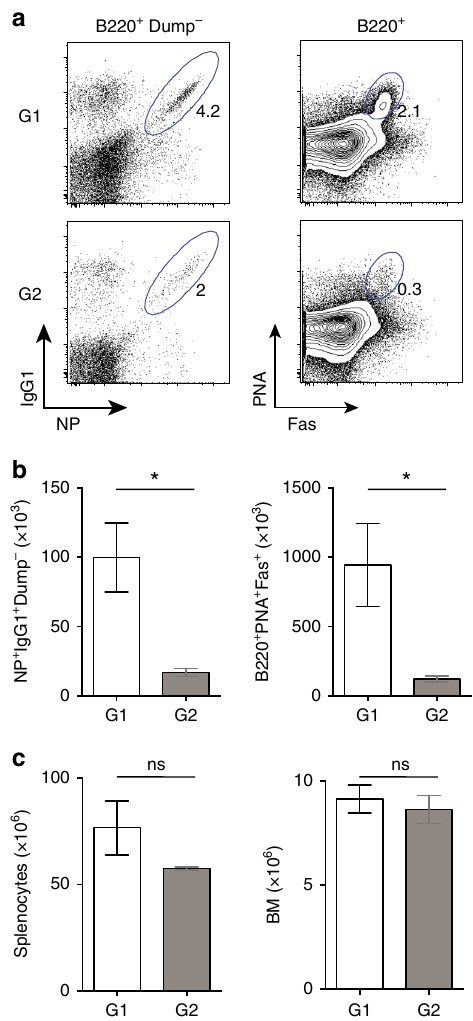
Fig. 6 PRMT1 is required to mount a recall immune response. a – c Irradiation chimeras were generated with 80% of µ MT and either 20% of Prmt1 + / + Rosa26CreERT2 (G1;+ / + ) or 20% Prmt1 f/f Rosa26CreERT2 (G2; f/f ) BM cells. Nine weeks post BM reconstitution; mice were immunized with NP-KLH in alum. Nine weeks after immunization mice were treated for 3 days with single doses of Tamoxifen to induce Prmt1 deletion and then boosted with NP-KLH in PBS, injected i.p. a Representative fl ow cytometry plots of splenocytes 5 days after NP-KLH boost are shown. Frequencies of NP + IgG1 + (left) and total GC (B220 + Fas + PNA + ) (right) among B220 + IgM − IgD − Gr1 − cells and B220 + cells, respectively, are indicated. Numbers represent percentages of the displayed events within indicated gates. b , c Average numbers of NP + IgG1 + B-cells, GC B cells, total splenocytes per spleen and per femur are shown in the graphs. * P ≤ 0.05; ns = not signi fi cant (unpaired t -test). Mean and s.e.m. ( b , c ). The experiment comprised fi ve mice per group. Flow cytometry gating strategies for this fi gure are shown in Supplementary Fig.